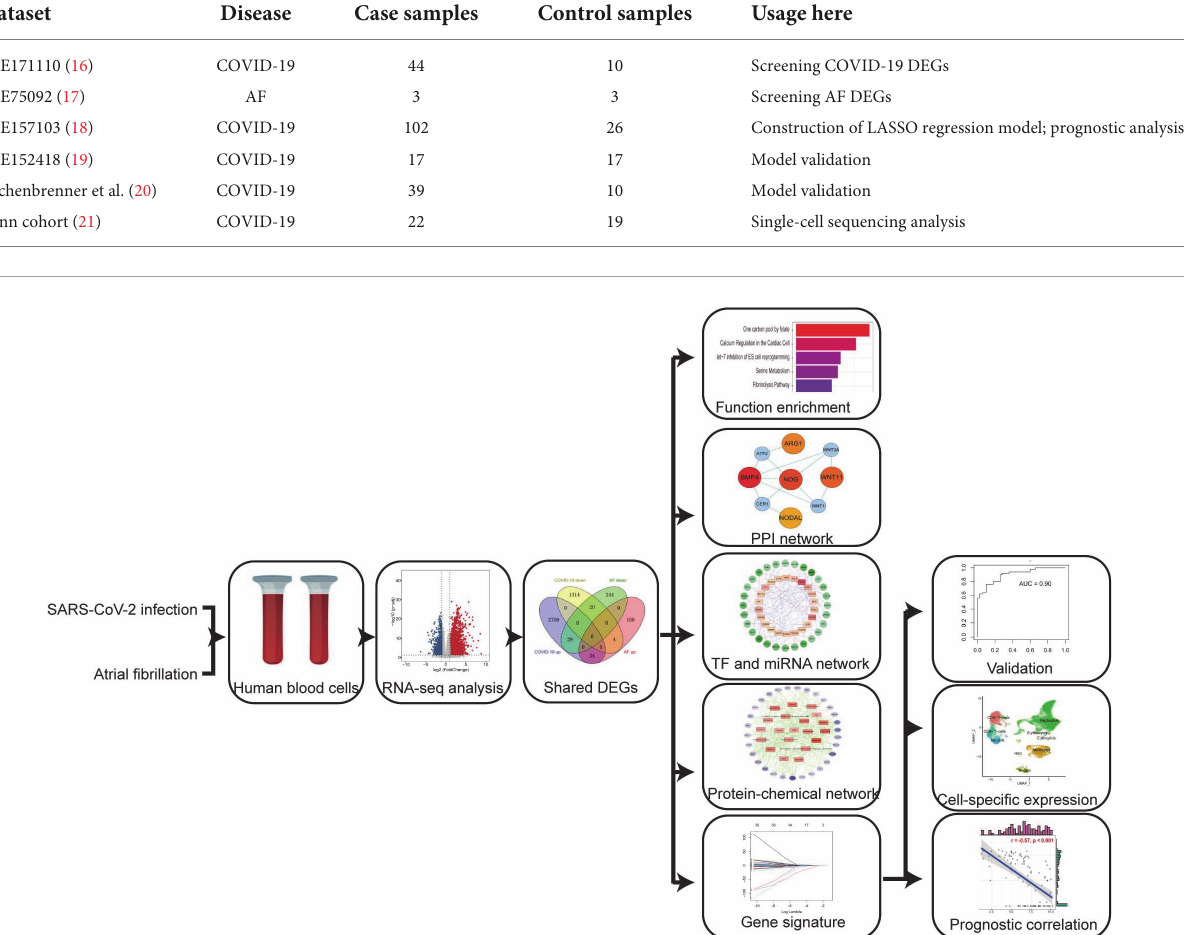
FIGURE1 A systems bioinformatics approach was used to analyze the differentially expressed genes (DEGs) and associated pathways shared between COVID-19 and AF. Shared DEGs were used to identify protein-protein interaction (PPI) networks, gene regulatory networks (GRN), and protein-chemical interactions, and to construct AF-associated gene signatures to assess the severity of COVID-19. Localizing these genes expression by scRNA-seq and assessing their prognostic relevance.